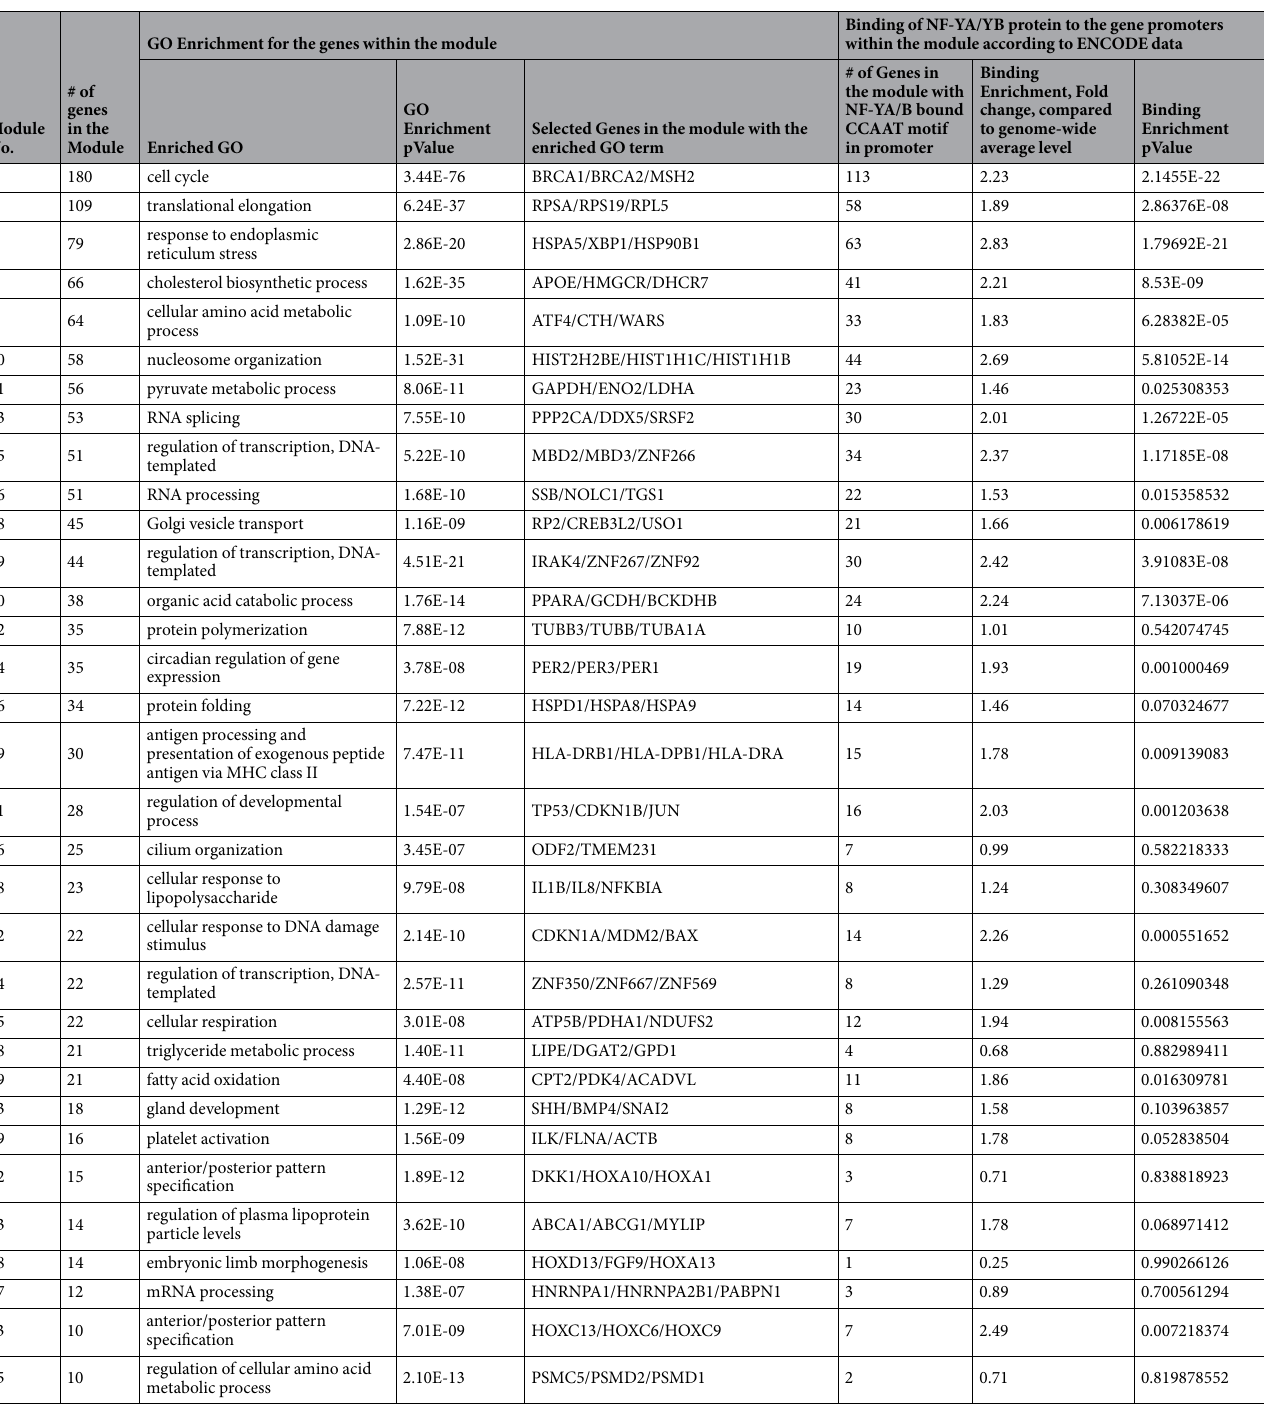
Table 1. NF-Y motif (CCAAT)-regulated